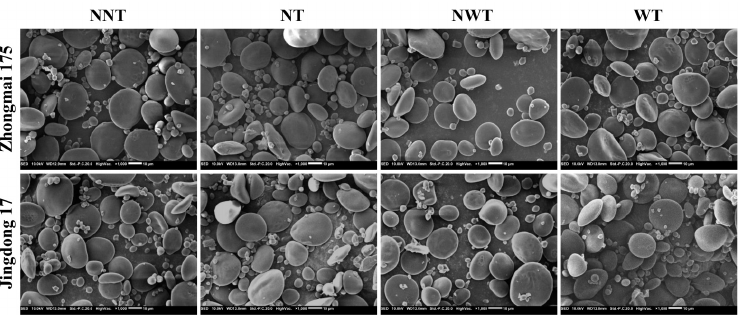
Figure 1. Scanning electron microscope images (1000× magnification) of starch granules isolated from Zhongmai 175 and Jingdong 17 subjected to non-nitrogen (NNT), reduced nitrogen (NT), non-water (NWT), and reduced water (WT) treatments.